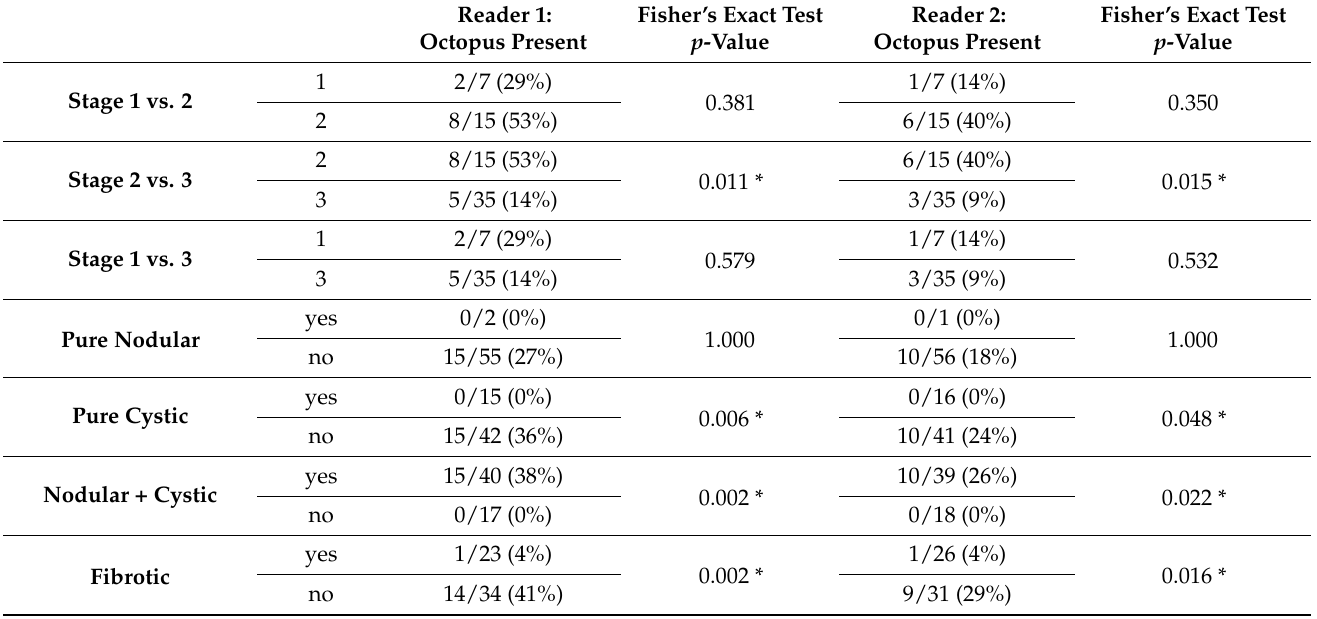
Table 2. Frequency of the octopus sign across the different PLCH stages and across the nodular, cystic, and fibrotic patterns for both readers and for a high certainty of the octopus sign. Reader 1: Fisher’s Exact Test Reader 2: Fisher’s Exact Test p -Value p Octopus Present Octopus Present